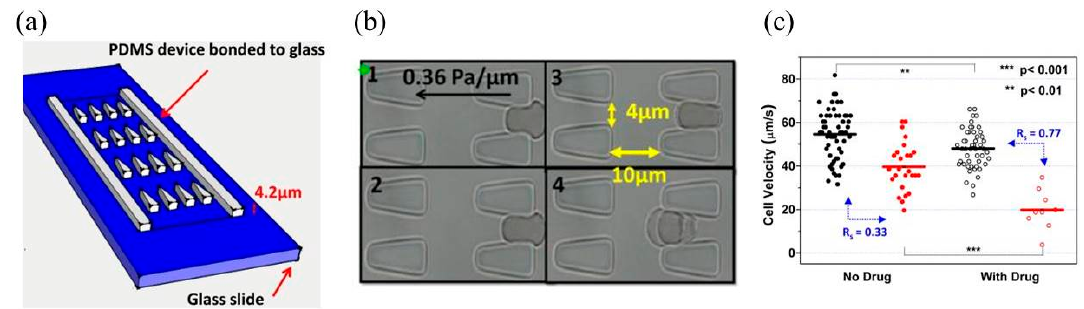
Figure 2. ( a ) Schematic of the geometry of the parallel constriction channel design; and ( b ) experimental images of RBCs passing through constriction positions; ( c ) The treatment of Artesunate significantly decreases the cell velocity of Plasmodium falciparum infected RBCs while it has no significant effect on uninfected RBCs. Reproduced with permission from [31].